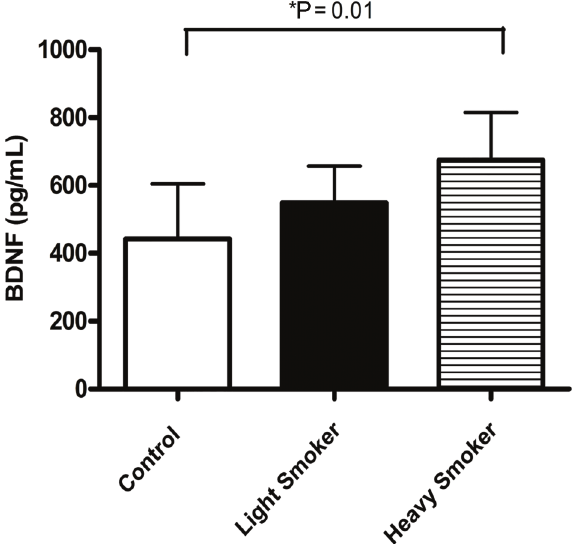
Figure 1. Plasma brain-derived neurotrophic factor (BDNF) levels in control and smoker groups. The plasma BDNF levels in the heavy smokers (674.4 ± 140.7 pg/mL) were signi fi cantly higher than that of the control group (441.7 ± 163.0 pg/mL). No difference was observed between light smokers and control and between light and heavy smokers. Data are reported as mean ± SD. *P o 0.05